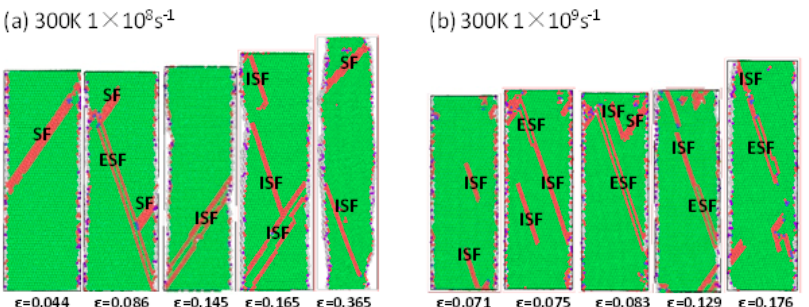
Figure 7. The CNA diagram of non-GBs HEAs under tensile. ( a ) 300 K, 1 × 10 8 s − 1 ; ( b ) 300 K, 1 × 10 9 s − 1 .